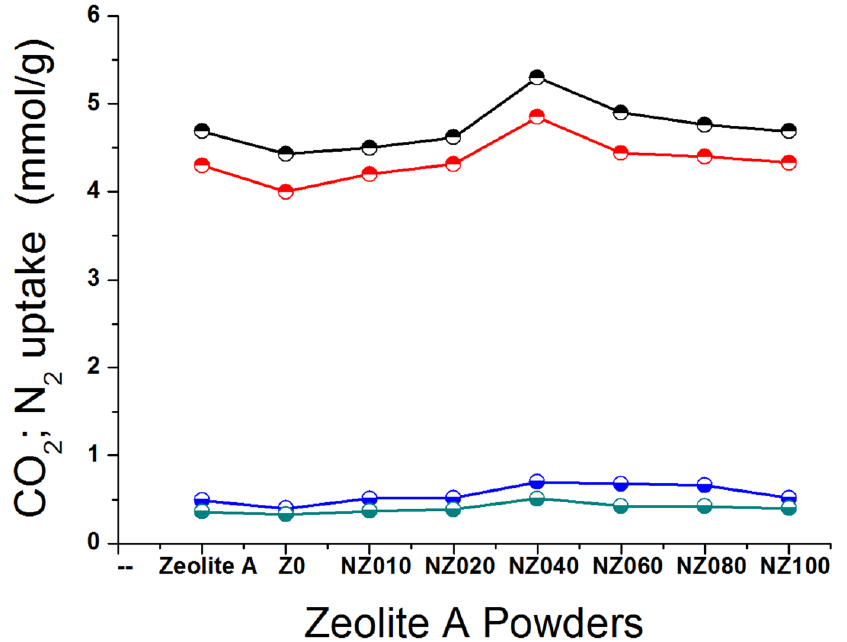
Figure 5. CO and N uptake of different nano- and micron-sized zeolites at 273 and 2 2 293 K; uptake at 293